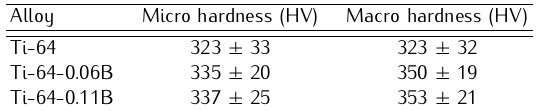
Table 3. Micro- and macro hardness results in as received